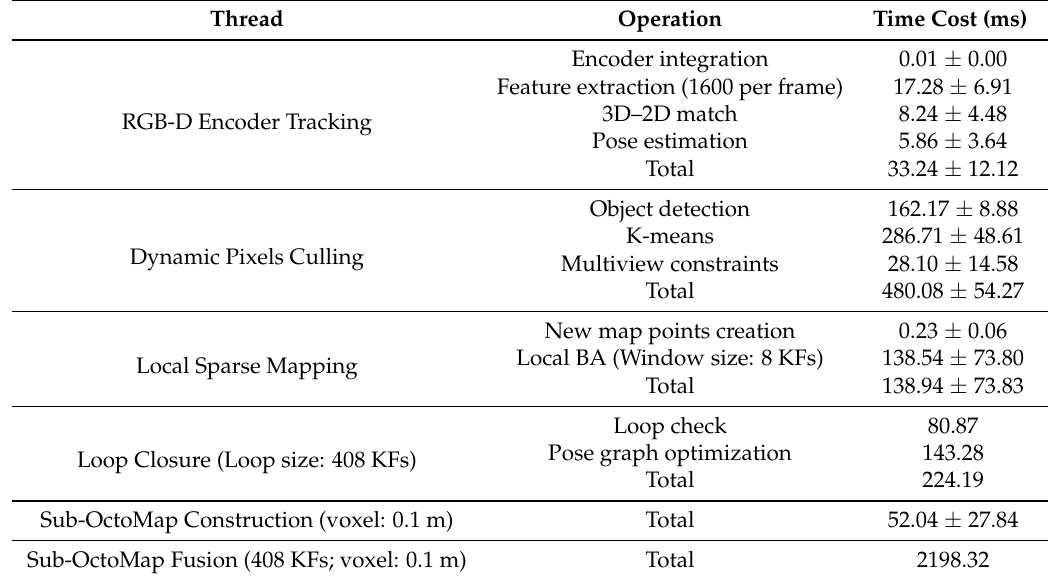
Table 4. Timing results of each thread in milliseconds (mean ±